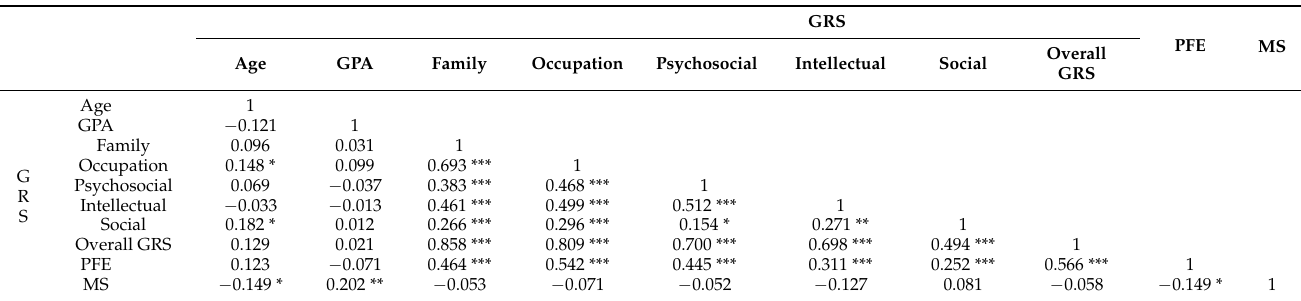
Table 3. Correlation between general characteristics, gender role stereotypes, patriarchal family environment, and MS ( n =